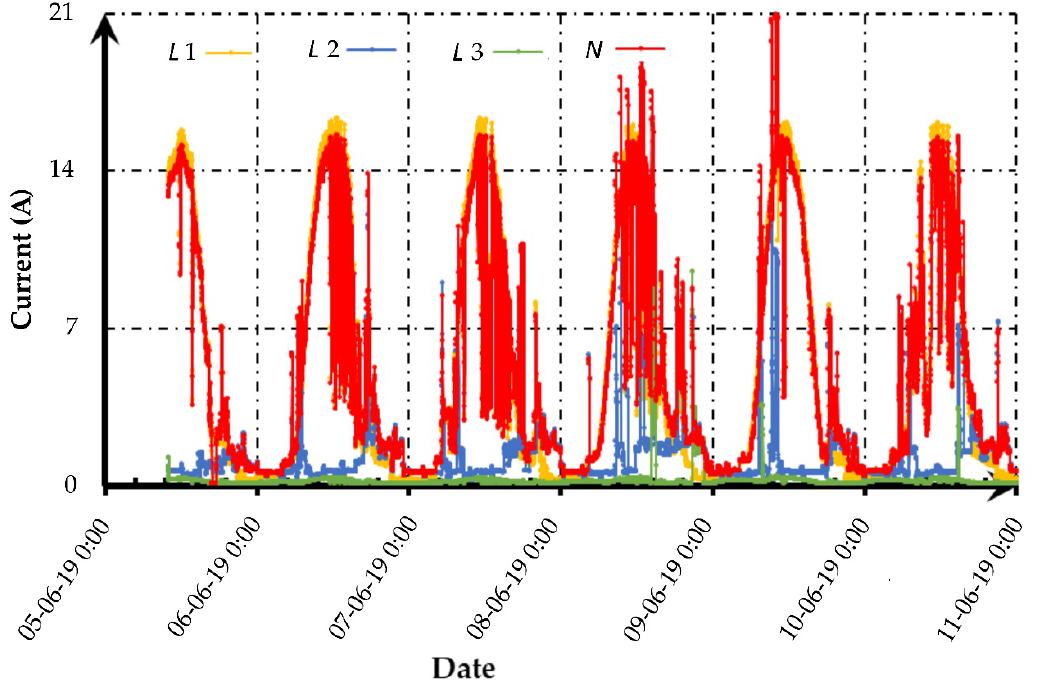
Figure 9. Currents variation during measurements.